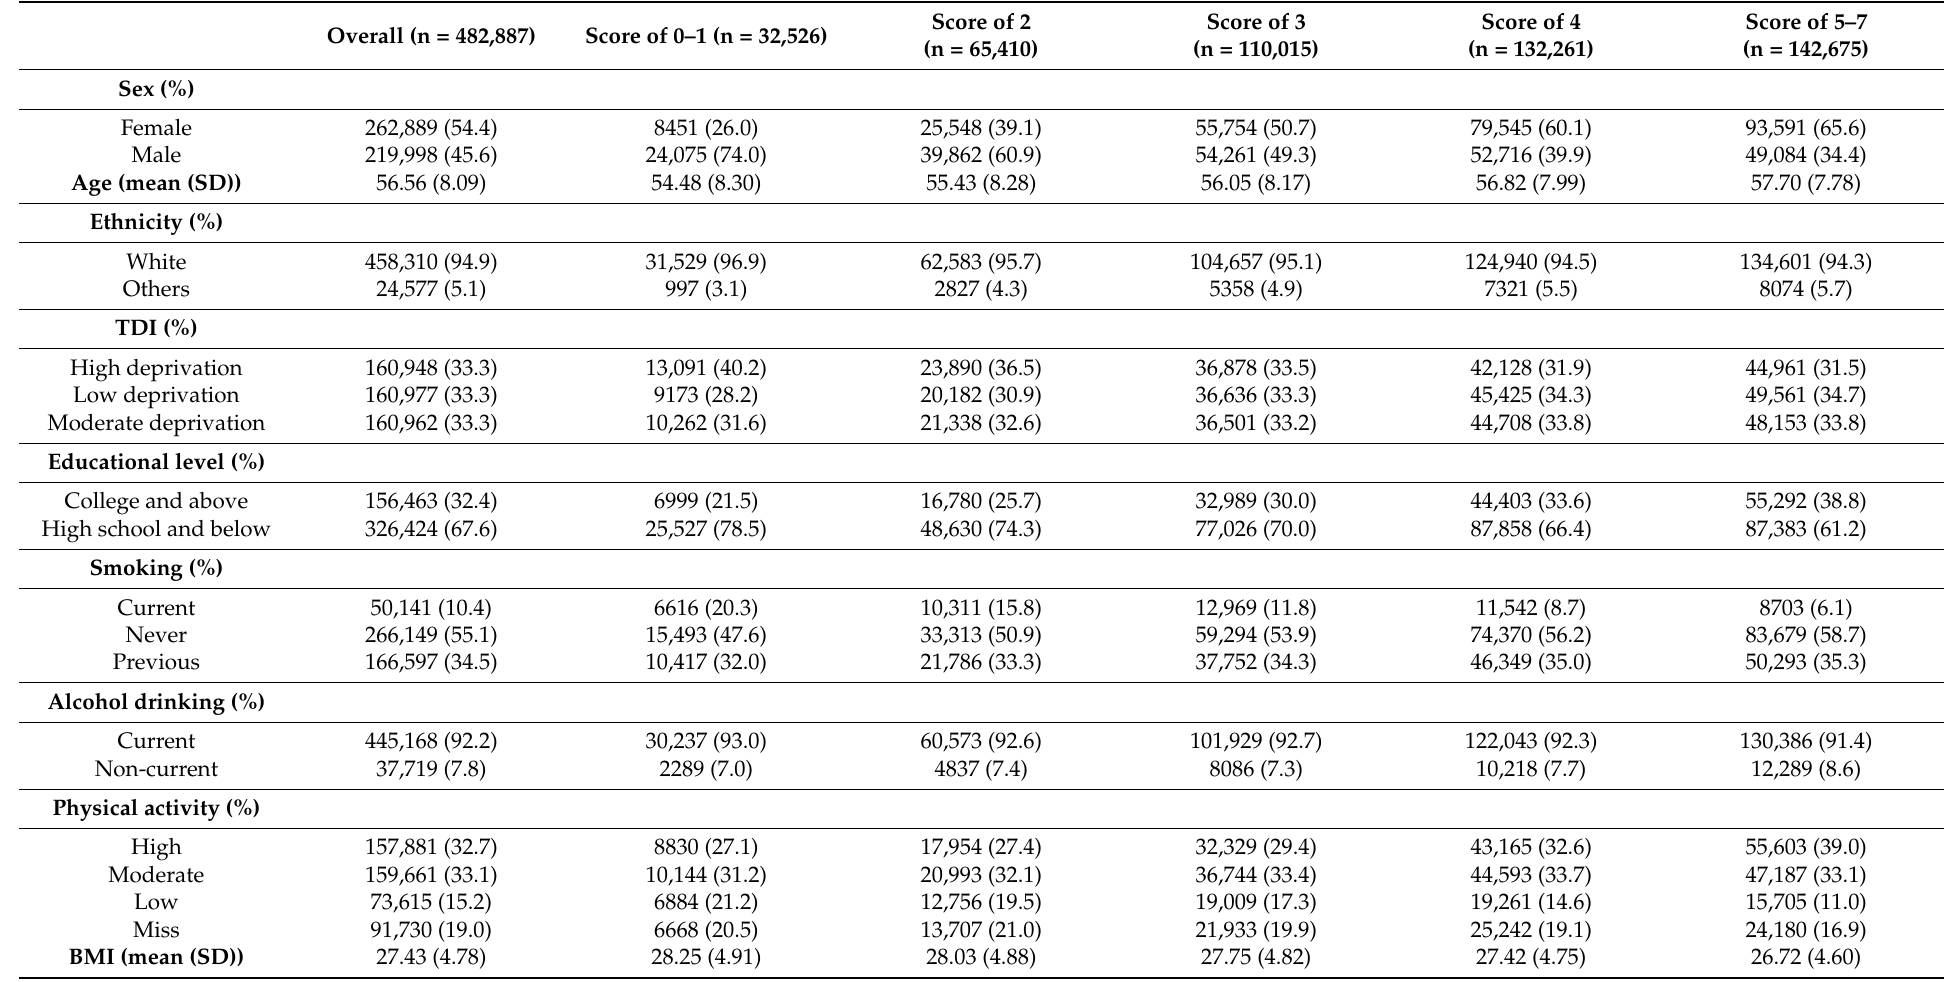
Table 1. Characteristics of all participants based on different cardioprotective diet